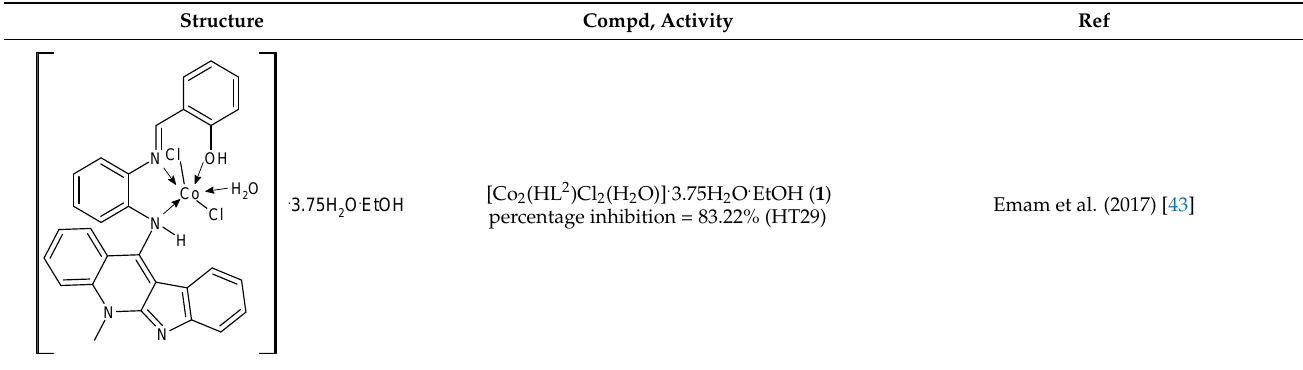
Table 1. Antiproliferative activity of Schiff base complexes with transition metals. Structure